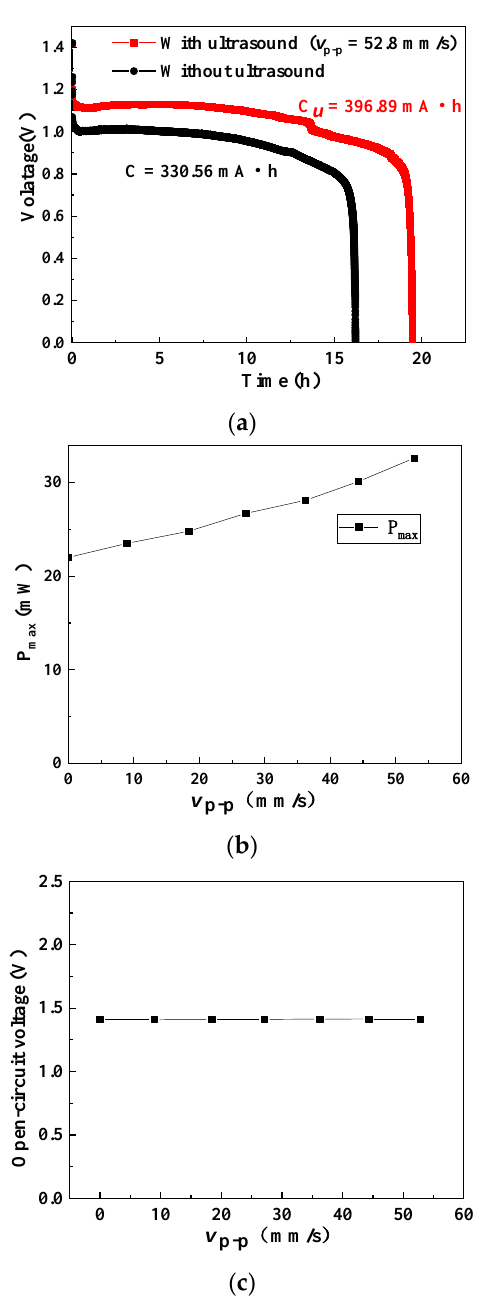
Figure 5. Measured characteristics of the ultrasonically excited button zinc–air battery. ( a ) Discharge profile under a constant discharging current (20.3 mA) with and without sonication. ( b ) Maximum power vs. ultrasonic vibration velocity. ( c ) Open-circuit voltage vs. ultrasonic vibration velocity.